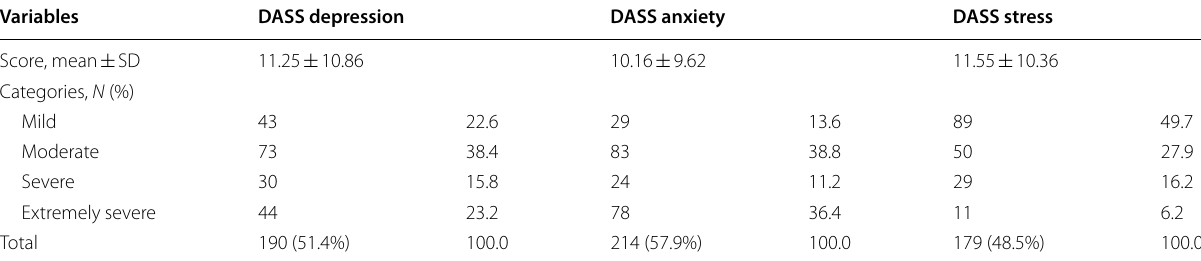
Table 3 Prevalence and severity of depression, anxiety and stress among the study participants as per DASS-21 scores ( N